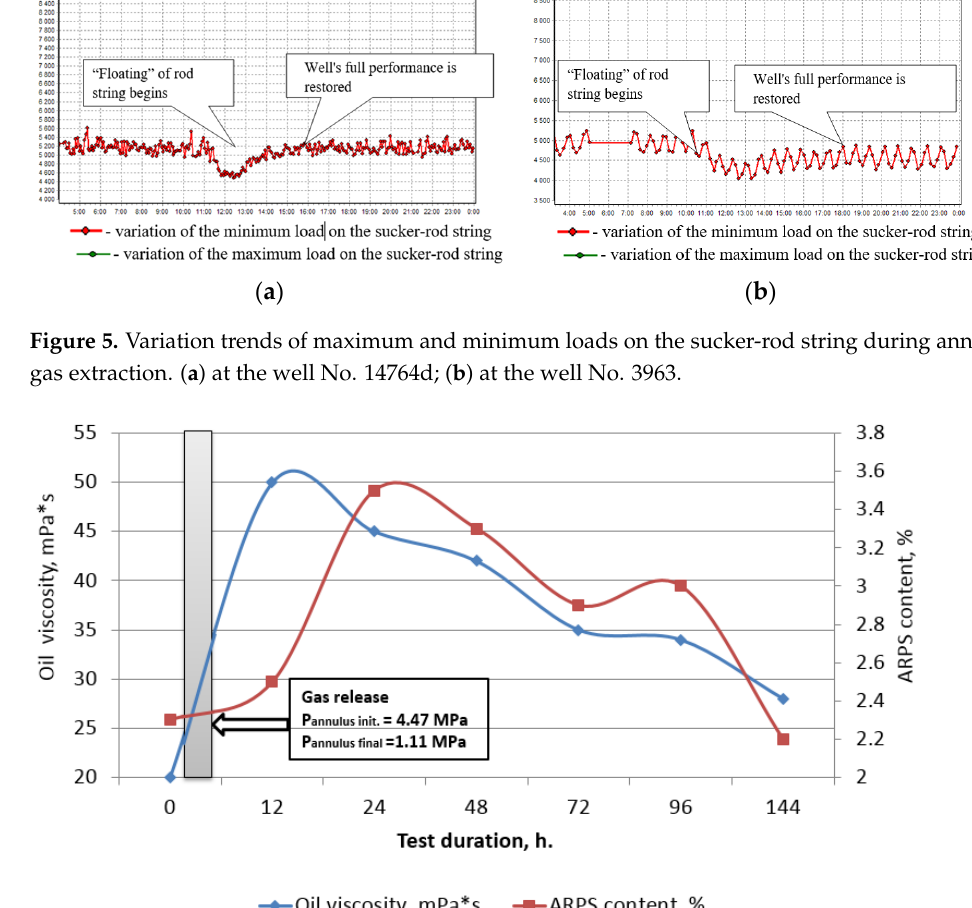
Figure 6. Variation of viscosity and ARPS content in oil after extraction of annular gas at the well No. 5597d.